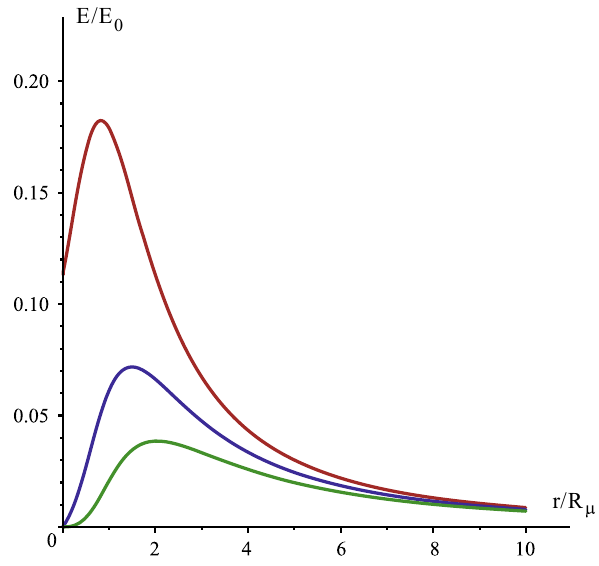
Fig. 2 Plots of the function E ( r )/ E 0 where E 0 = Q the electric field is regular at the center. The upper curve relates to the critical value of the parameter α , α = 1; the electric field at the center is finite but nonvanishing for α = 1. Two other plots relate to the values α = 2 and α = 3 ( bottom curve ); In these cases the electric field takes the zero value at the center. For presented plots the mass value is chosen to be equal to M = 0 . 5 R